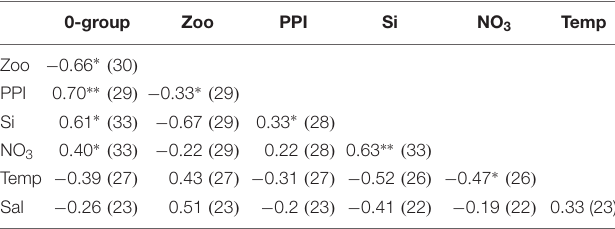
TABLE 3 | Correlations ( r ) between yearly values in 0-group length index, zooplankton biomass, PPI, oceanic pre-bloom silicate and nitrate concentration, temperature, and salinity.